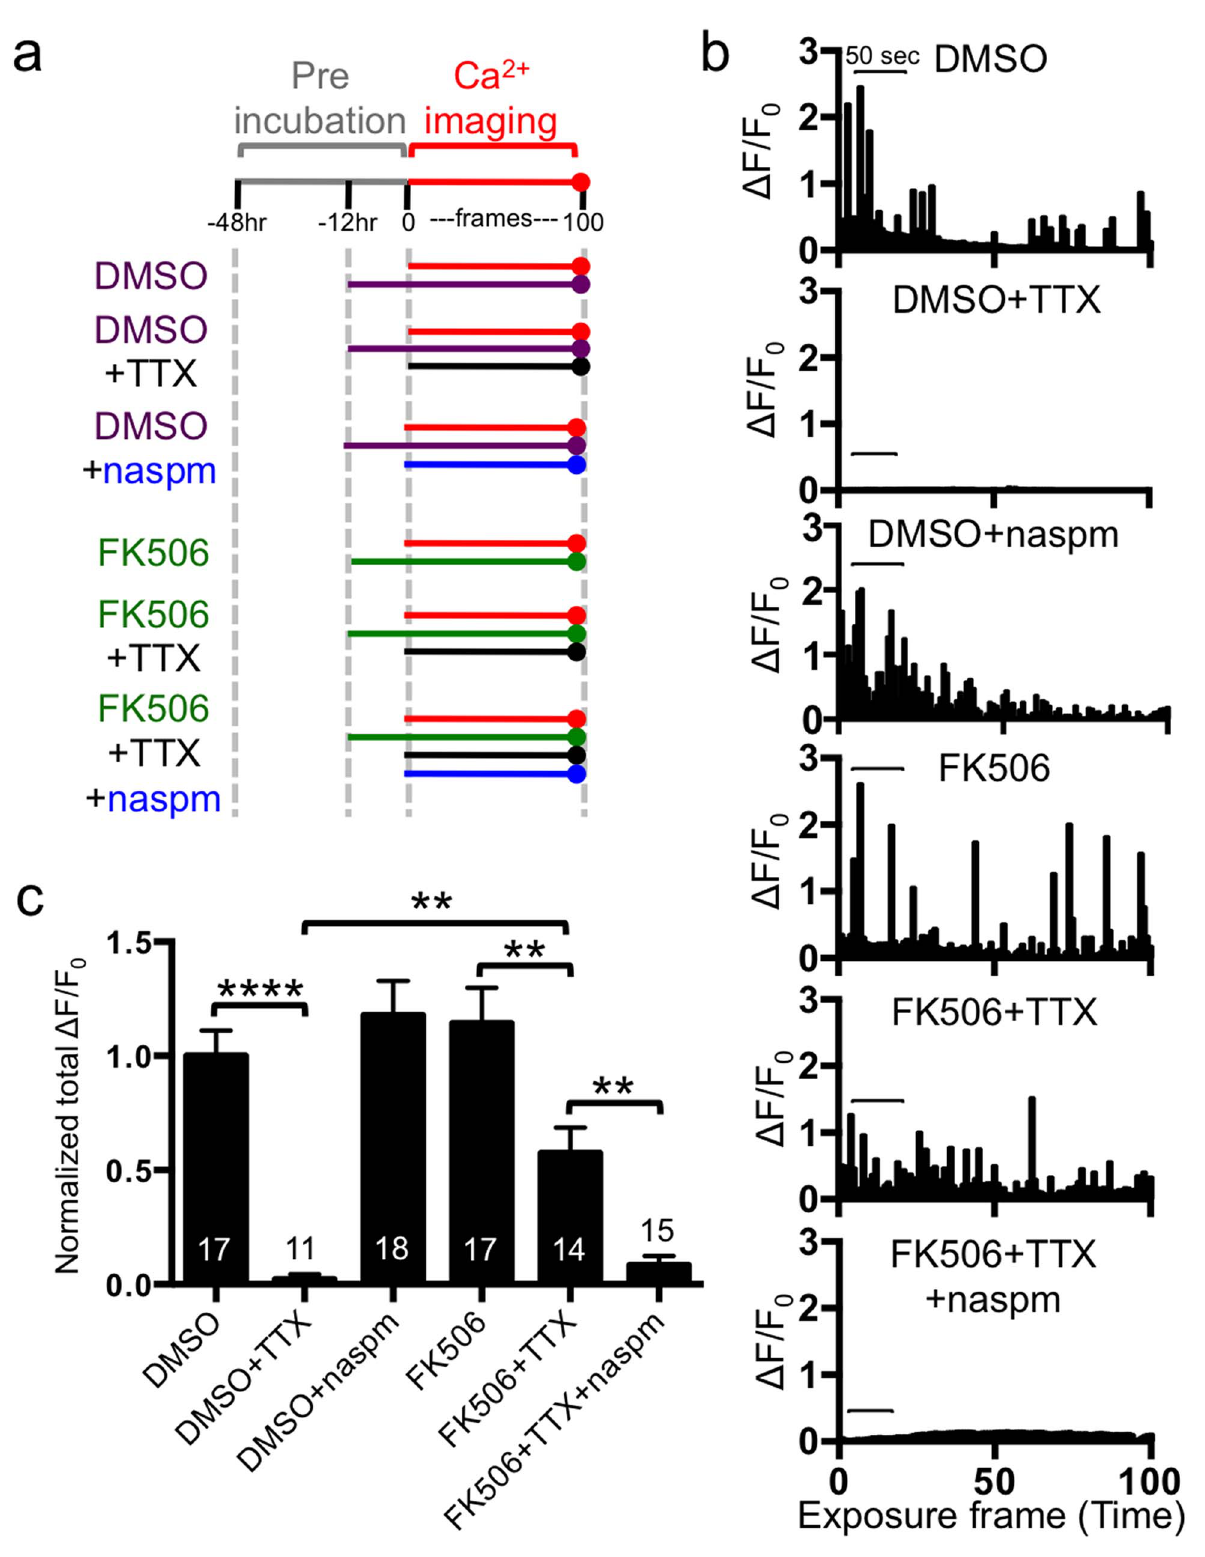
Figure 8. Synaptic scaling restored Ca 2 + signals via FK506-induced CPARs. (a) Schematic of Ca 2 + imaging protocol. A red line indicates Ca 2 + imaging, a purple line shows the presence of DMSO, a black line represents the addition of TTX, a blue arrow shows the treatment of napsm, and a green line reveals the incubation of FK506. (b) Example bar graphs of Ca 2 + activity in each condition. Each bar represents the GCaMP5 fluorescence intensity detected in a single exposure frame. Scale bars are 50 s. (c) Normalized average of total Ca 2 + activity in each condition ( n =number of neurons, ** p , .01 and **** p , .0001, one-way ANOVA, uncorrected Fisher’s LSD).